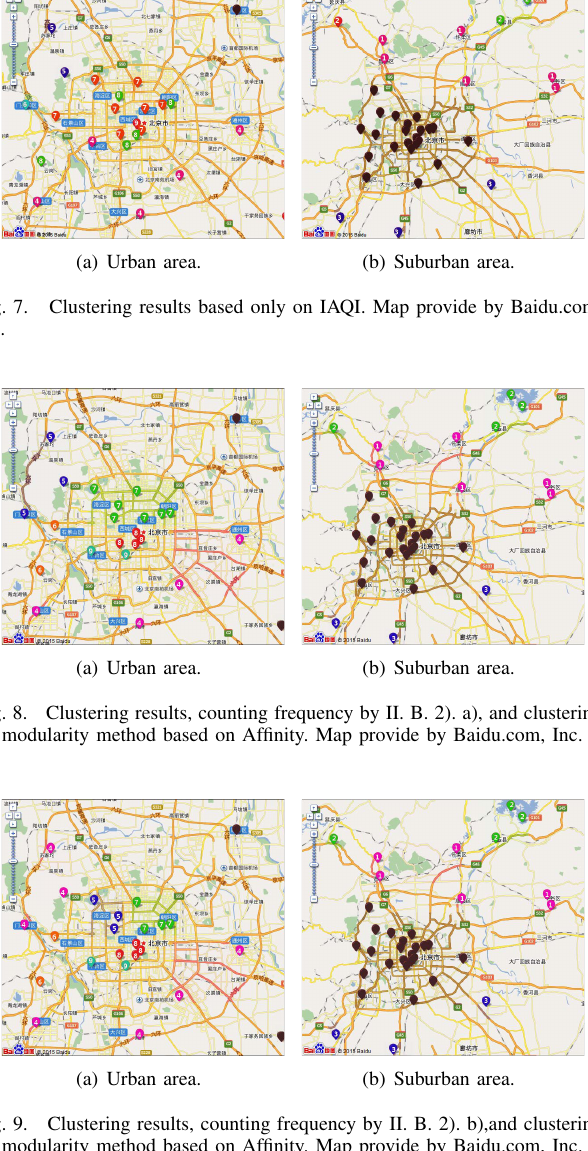
Fig. 9. Clustering results, counting frequency by II. B. 2). b),and clustering by modularity method based on Affinity. Map provide by Baidu.com,